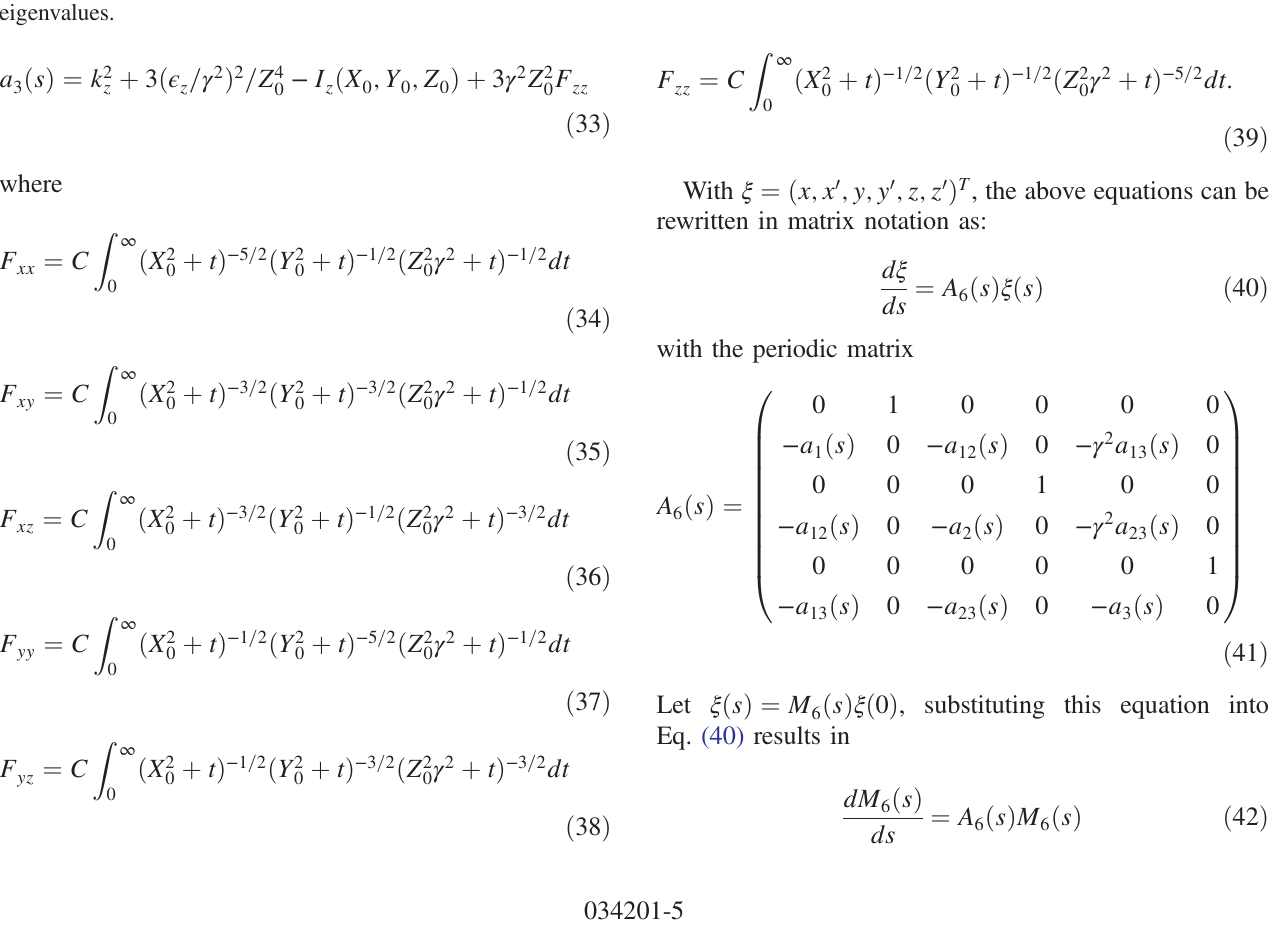
FIG. 3. The 3D envelope mode phases as a function of depressed transverse phase advance with (a) 80 °, (b) 100 °, (c) 120 °, and (d) 140 ° zero current longitudinal and transverse phase advances in a periodic solenoid-rf channel. The six colors are the phases of the six